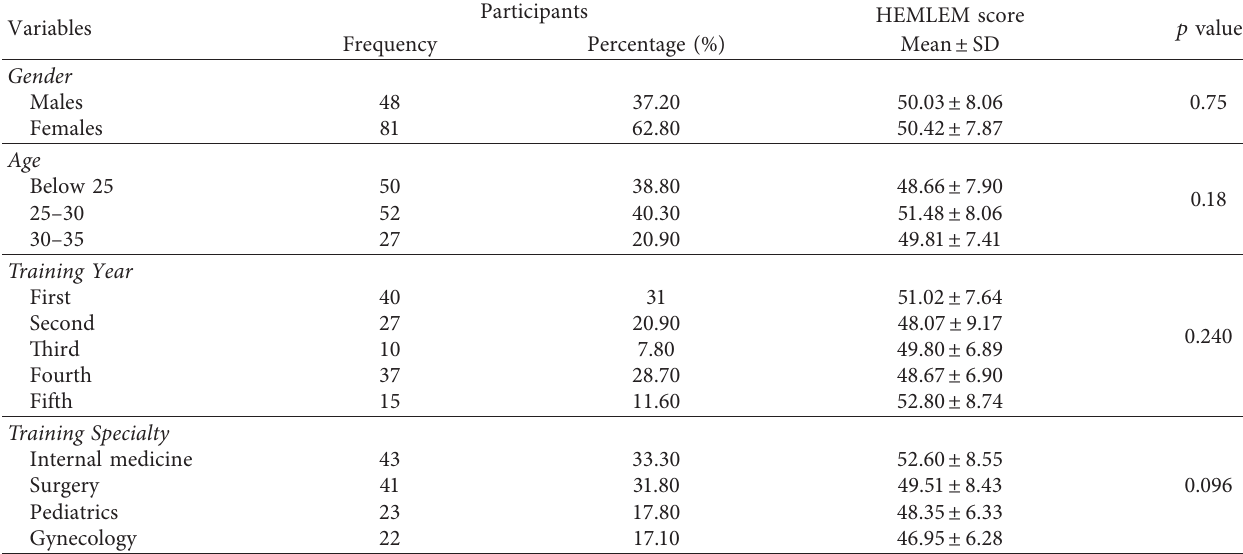
Table 1: Demographic characteristics of the participants and HEMLEM scores achieved.